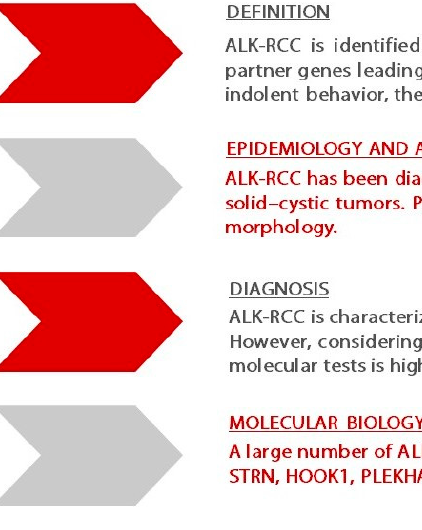
Figure 1. Summary of ALK-RCC features adapted from the “GUPS update on renal neoplasia”— Ref. [6]. Abbreviations: ALK—anaplastic lymphoma kinase; ALK-RCC—renal cell carcinoma associ- ated with ALK gene rearrangements; CLIP1—cytoskeleton-associated proteins-Gly domain contain- ing linker protein 1; EML4—echinoderm microtubule-associated protein-like 4; FISH—fluorescence in situ hybridization; GUPS—Genitourinary Pathology Society; HOOK1—hook microtubule tethering protein 1 kinase; IHC—immunohistochemistry; KIF5B—kinesin family member 5B; PLEKHA7— Pleckstrin homology domain containing A7; STRN—striatin calmodulin ‐ binding pro ‐ tein ; TPM3—tropomyosin 3; VCL—vinculin.